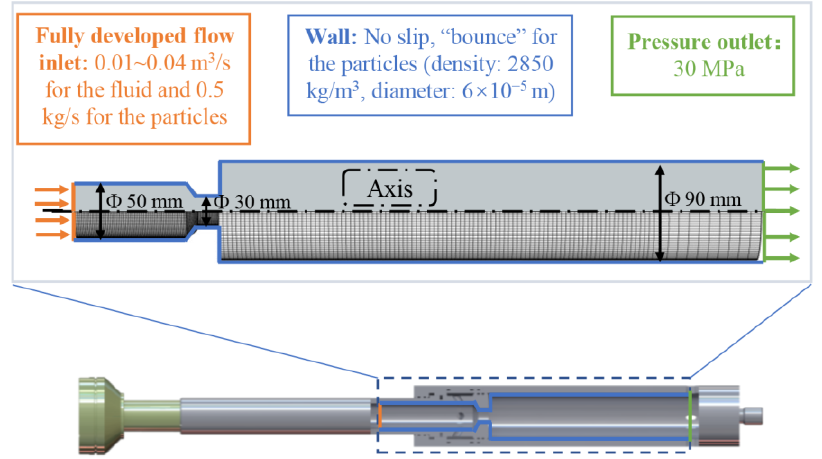
Figure 2. Mesh and boundary conditions of the flow domain in the differential motion assembly.